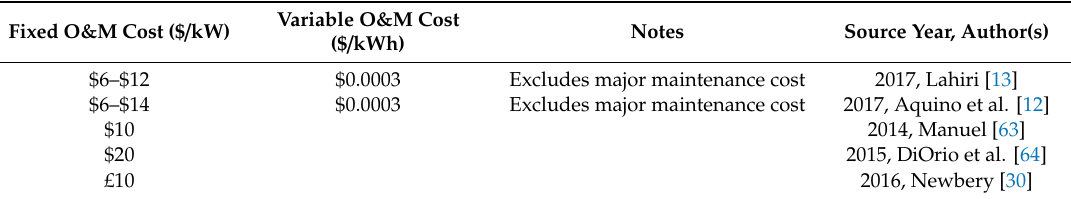
Table 13. Fixed and variable O&M costs—lithium-ion